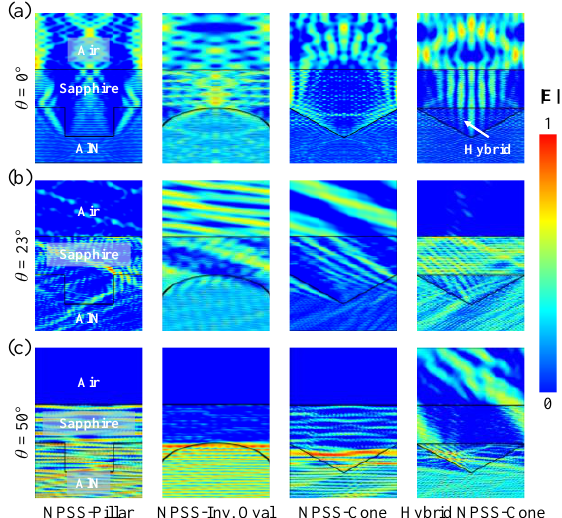
Figure 7. Normalized distributions of electric-field intensities for the four involved NPSS structures under three typical angles, i.e., θ = ( a ) 0°, ( b ) 23°, and ( c ) 50°.